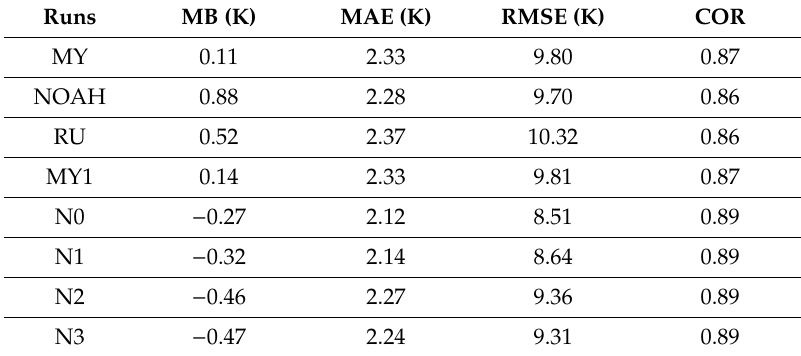
Table 4. Summary of the overall statistics between predicted and measured 2 m temperature at meteorological aviation reporting (METAR) stations in the Northern Sahara. Runs MB (K) MAE (K) RMSE (K) COR MY 0.11 NOAH 0.88